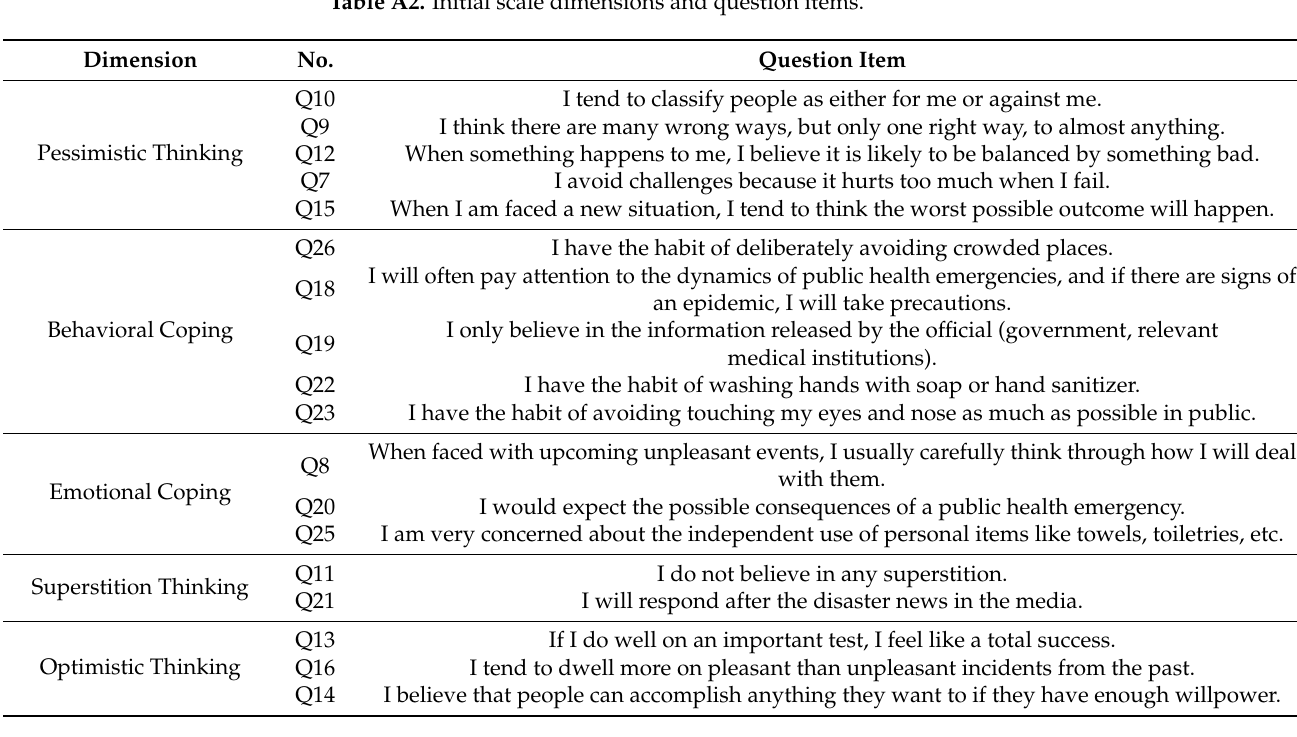
Table A2. Initial scale dimensions and question items.